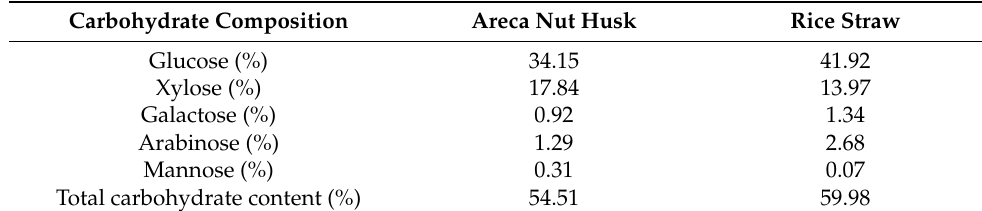
Figure 9. The molecular structure model of AHLC.